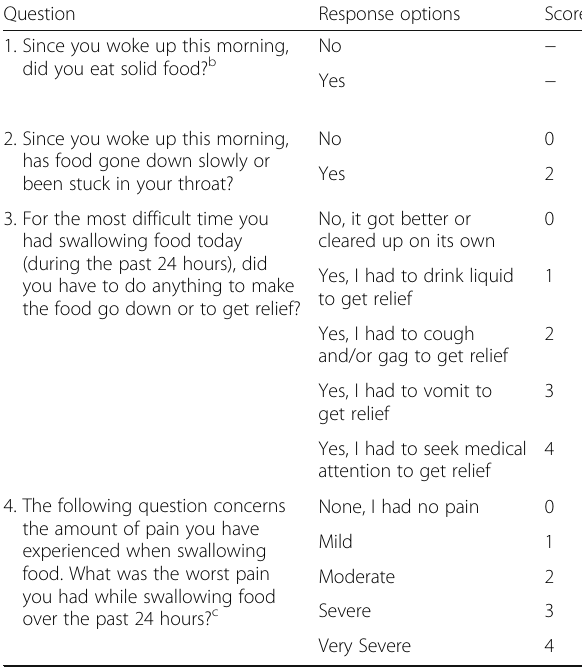
Table 1 The Dysphagia Symptom Questionnaire (version 4.0) and score for each response option